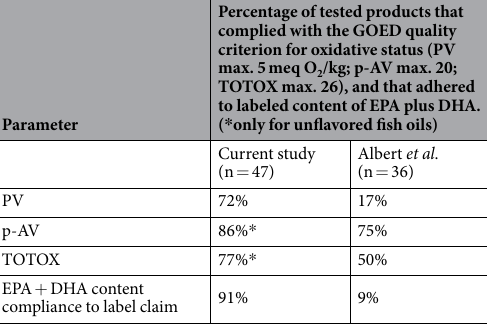
Table 5. Comparison of values of oxidative quality and EPA/DHA content in finished products available on the New Zealand market, as reported by Albert and colleagues and the current